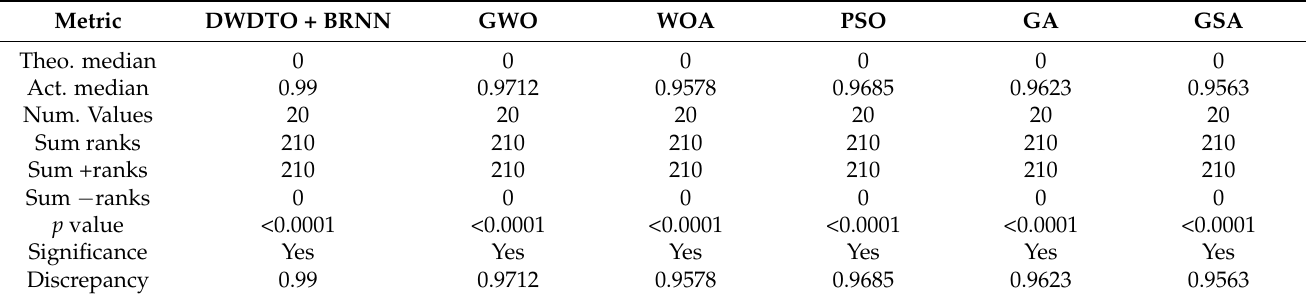
Table 7. Wilcoxon signed-rank test of the achieved results using the first dataset (D1).